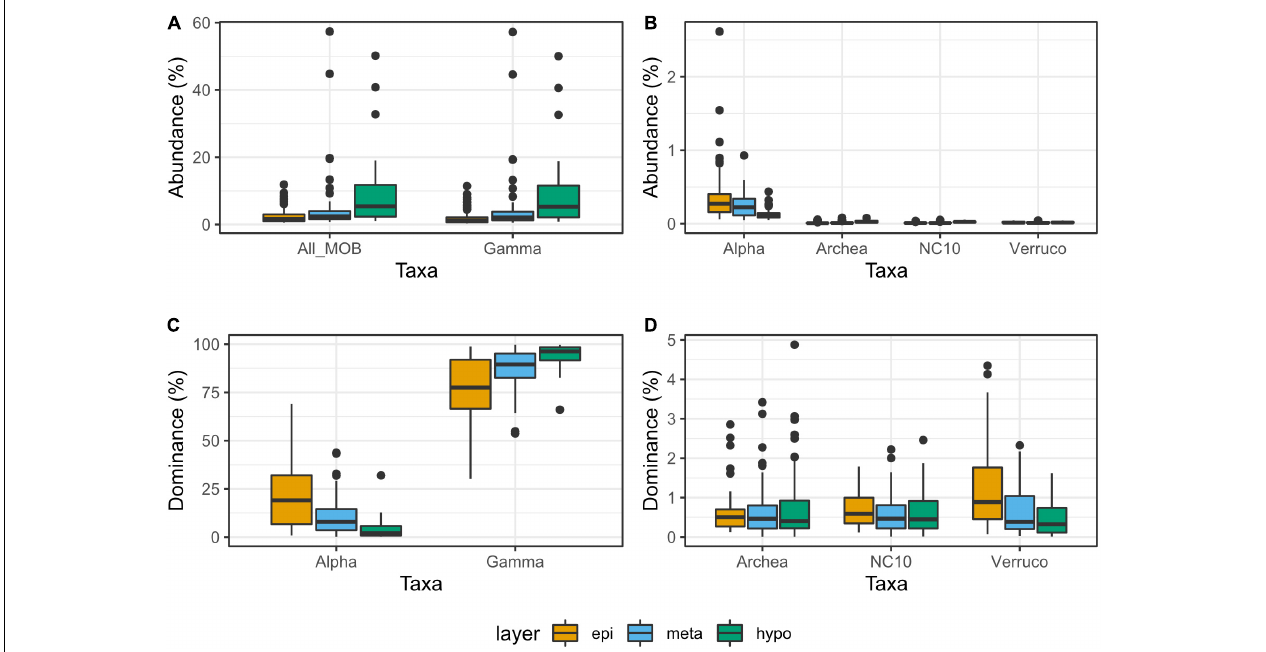
FIGURE 2 | Relative abundances (A,B) and dominances (C,D) of methane oxidizers (MO) observed in the different layers of the study lakes. Abundances are the proportions of reads attributed to MO in the whole dataset. Dominances are the proportions of reads attributed to a certain MO taxon among all the reads attributed to MO. The MO taxa include: alphaproteobacterial methanotrophs ( α -MO), gammaproteobacterial methanotrophs ( ), methanotrophic Archaea (MOA), bacterial phylum NC10 (NC10-MO), and Verrucomicrobial methanotrophs (V-MO). The lower, upper, and middle hinges correspond to the 25th, 75th, and median percentiles. The upper whisker extends up to the largest value, but not further than 1.5* the interquartile